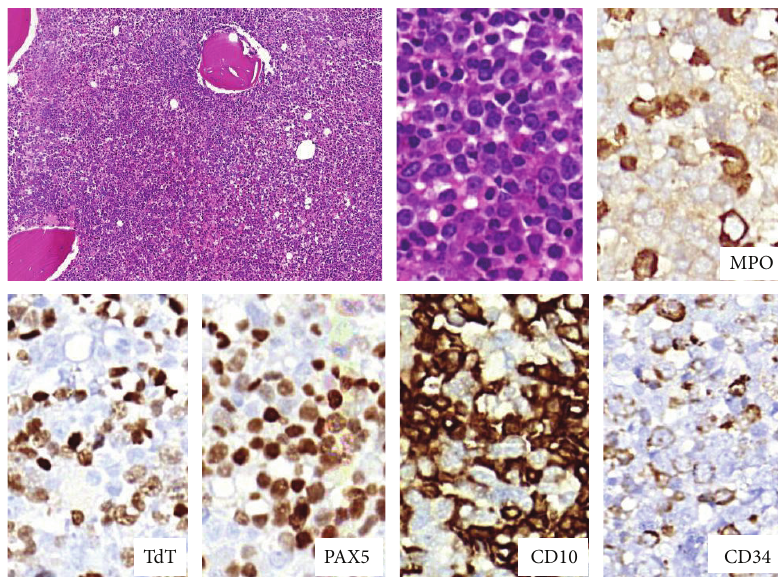
Figure 1: The bone marrow was diffusely infiltrated with blasts. Blasts strongly expressed TdT, Pax5, and CD10. CD34 was partially and weakly expressed by blasts. MPO was negative on blastic